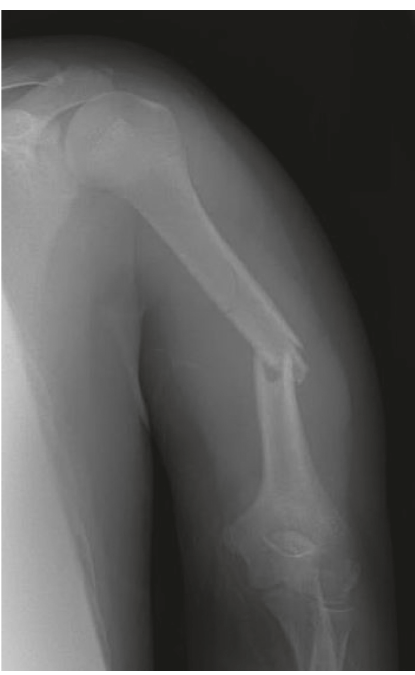
Figure 1: Anteroposterior radiograph showing a displaced mid- shaft humerus fracture in 35 ° varus angulation.